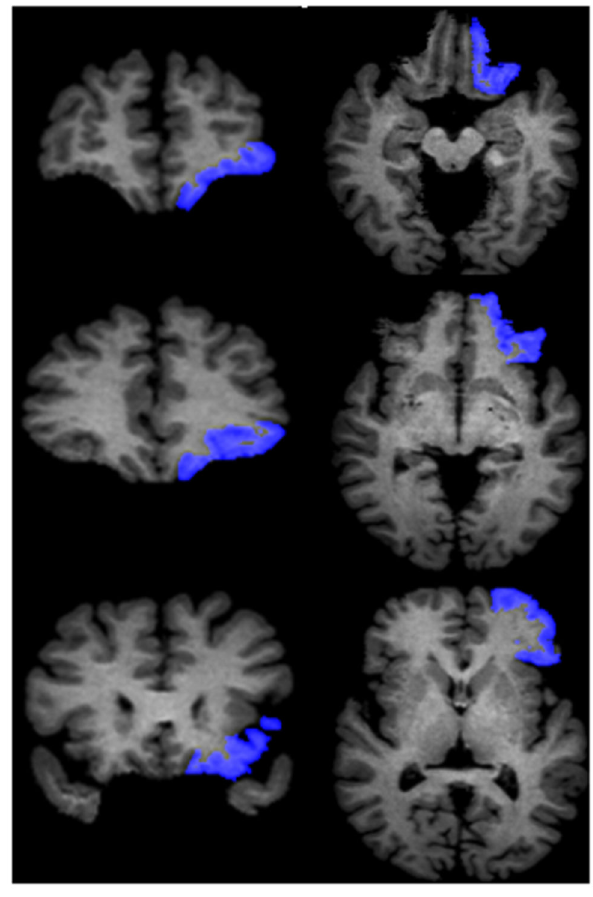
Figure 2. Delineation of the orbitofrontal cortex (OFC). Sample views of the OFC (in blue) at different coronal levels (left column) and transaxial levels (right column). Transaxial views were automatically reconstructed synchronously when the delineation was performed on consecutive coronal